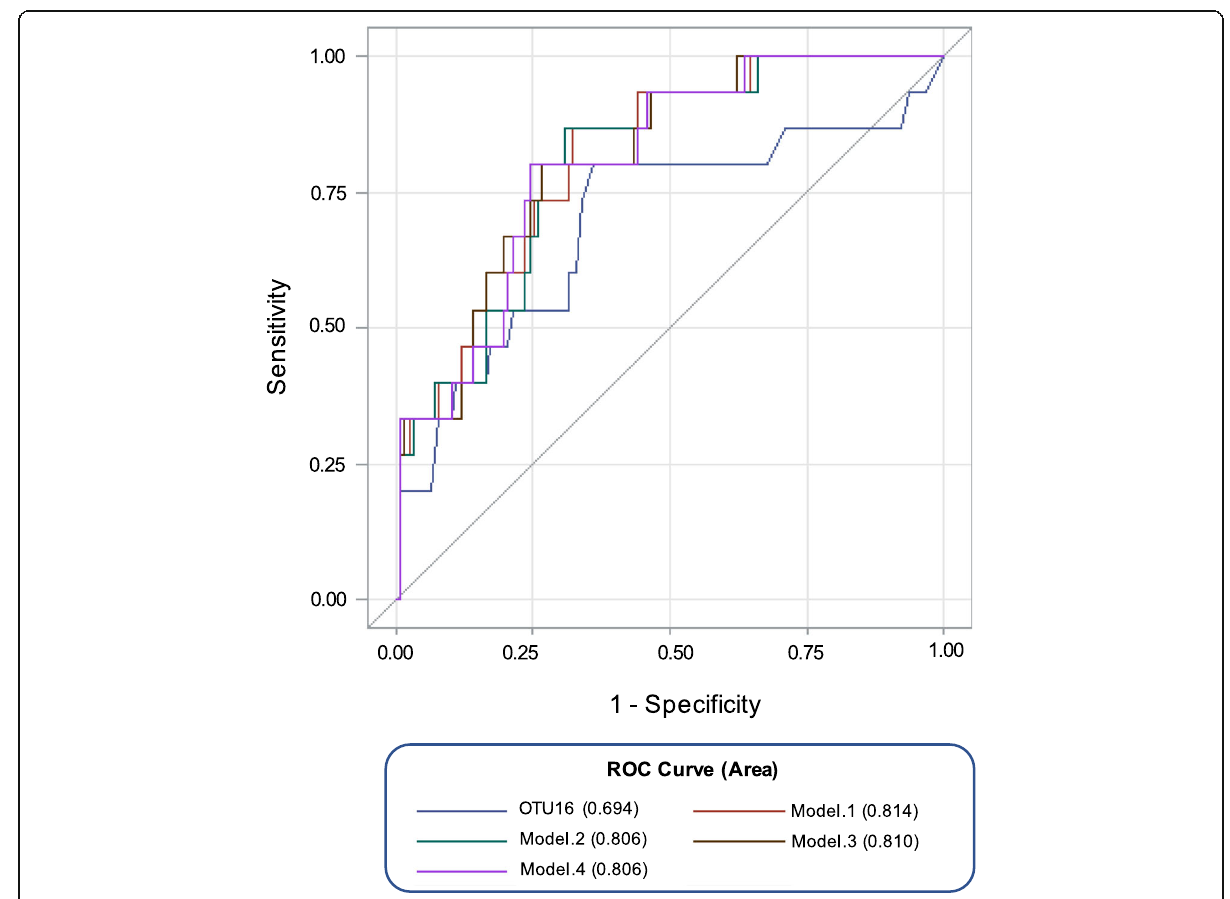
Fig. 6 Discriminatory power of selected OTUs for prediction of mastitis susceptibility. Receiver operating characteristics (ROC) curves and area under the curve (AUC) values were used to assess the discriminatory power of the relative abundances of selected OTUs (foundation OTUs and/ or OTUs that were associated with the incidence of clinical mastitis during the 90-day post-sampling record keeping period) to predict susceptibility to clinical mastitis. Color codes represent the logistic regression models that were used for ROC analysis: “ blue ” denotes ROC based on the inclusion of OTU16, “ red ” denotes model 1: based on the combination of OTU16, OTU6366, and OTU978, “ green ” model 2: based on the combination of OTU16, OTU6366, OTU111, and OTU978, “ brown ” model 3: based on the combination of OTU16, OTU6366, OTU79, and OTU978, and “ purple ” model 4: based on the combination of OTU16, OTU6366, OTU79, OTU978, and OTU 111. The straight line represents the null